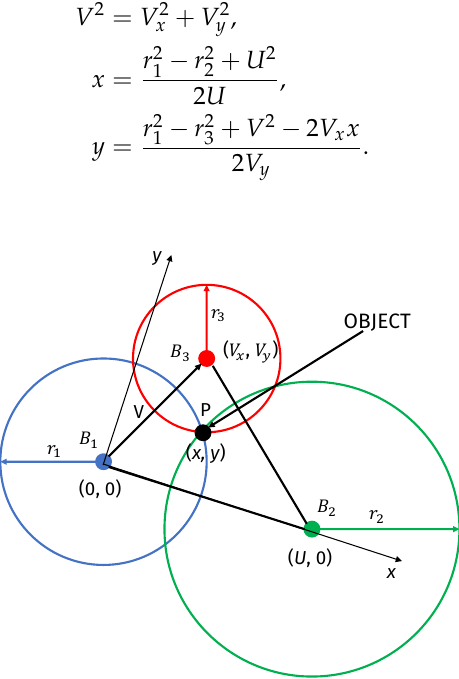
Figure 1. Trilateration algorithm for object localization using three beacons B 1 , B 2 , and B 3